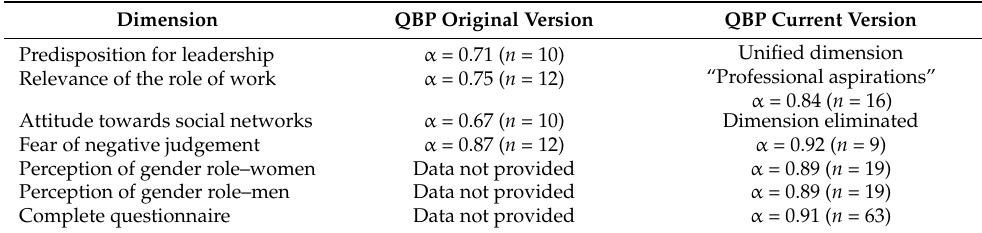
Table 3. Internal consistency of the